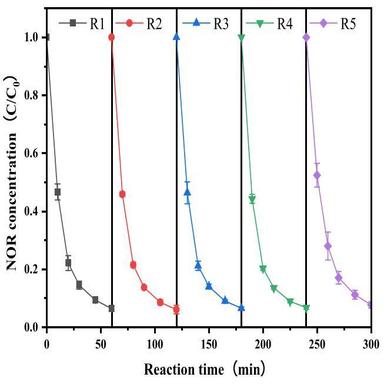
The cycle tests of CoFe@Eggshell.